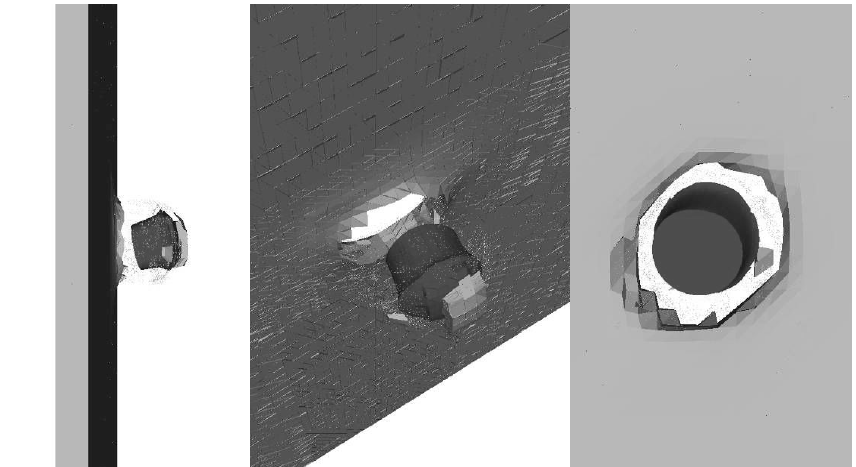
Fig. 6. Multiple views of FSP perforating a steel plate.